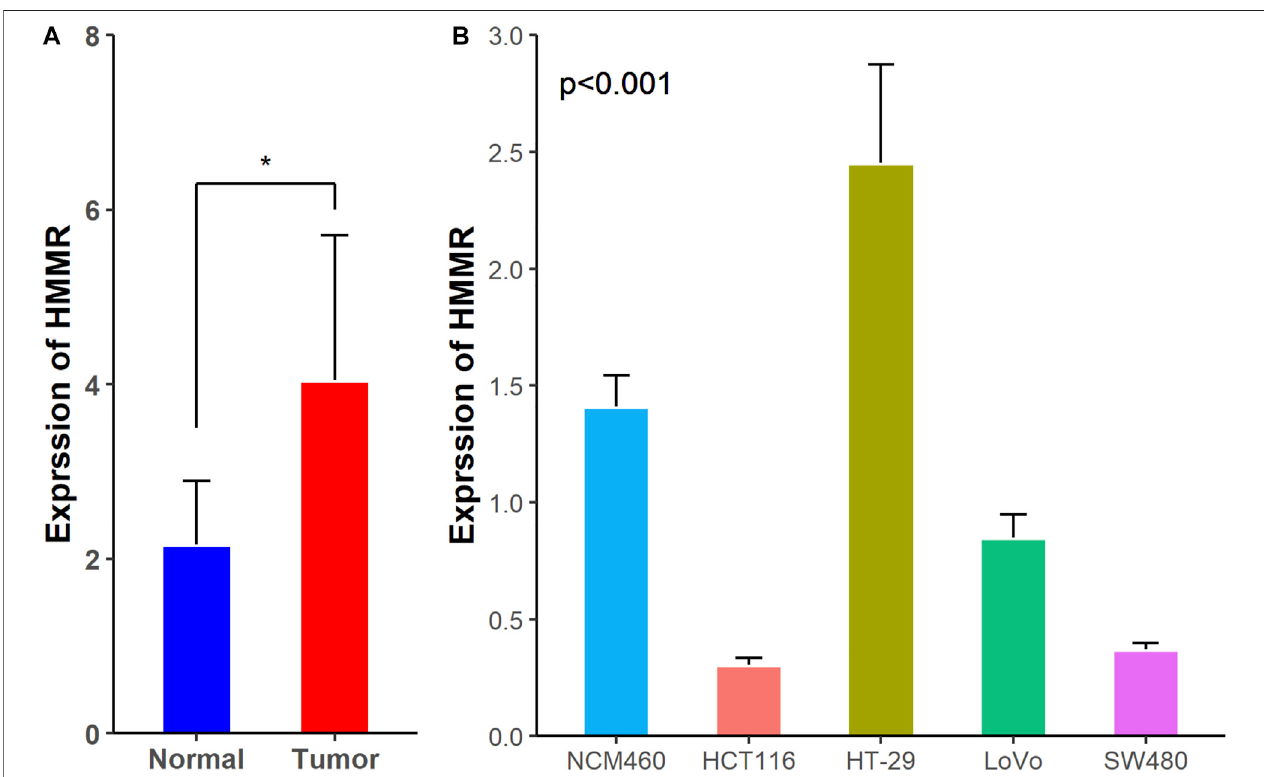
FIGURE 2 | Expression of HMMR mRNA in (A) clinical tissues and (B) CRC cell lines and colon mucosal epithelial cell line. * p < 0.05.